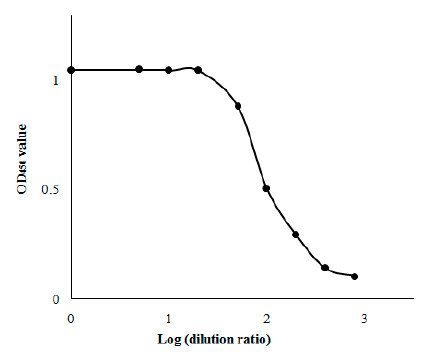
Figure 3. Optimization of HRP-naproxen dilution by the OD 450 values versus the logarithm of HRP-naproxen.